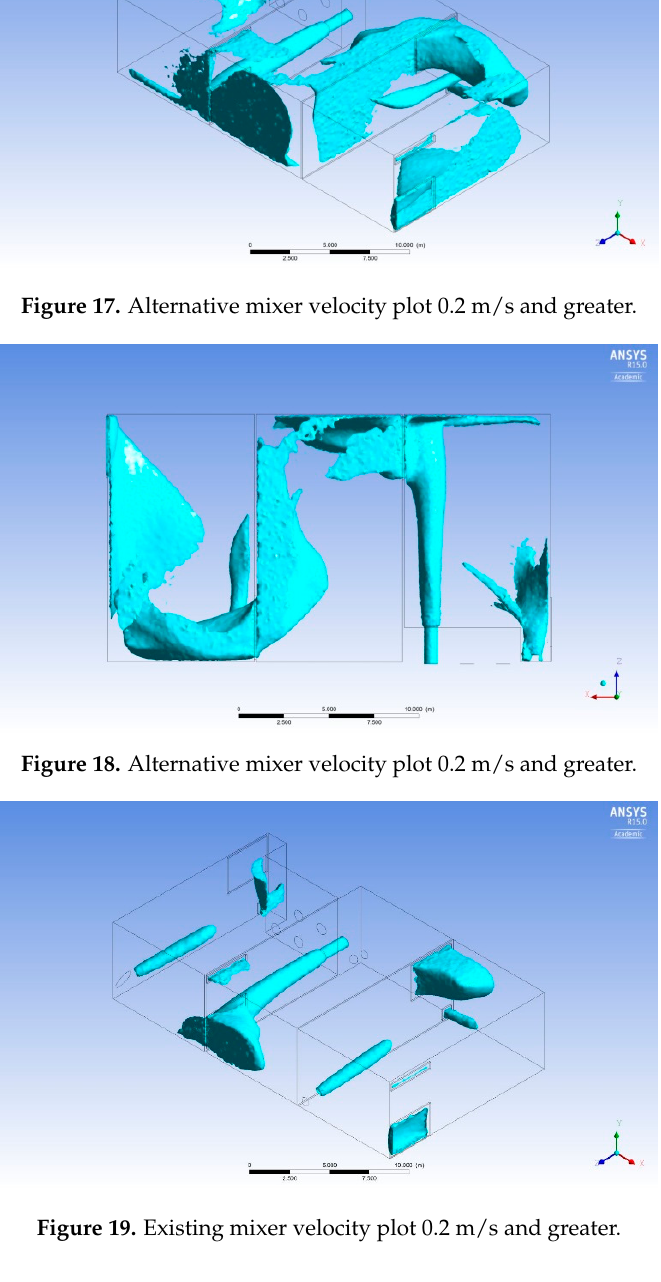
Figure 20. Existing mixer velocity plot 0.2 m/s and greater.